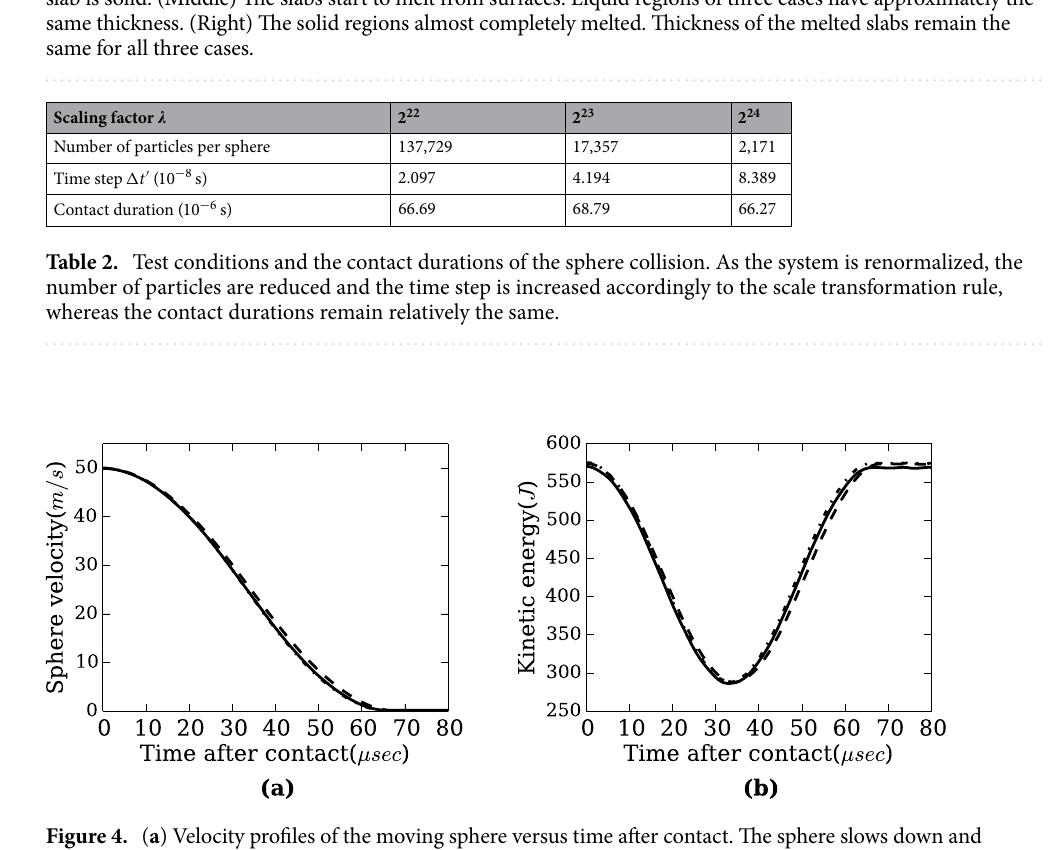
2 22 , (dashed line) =